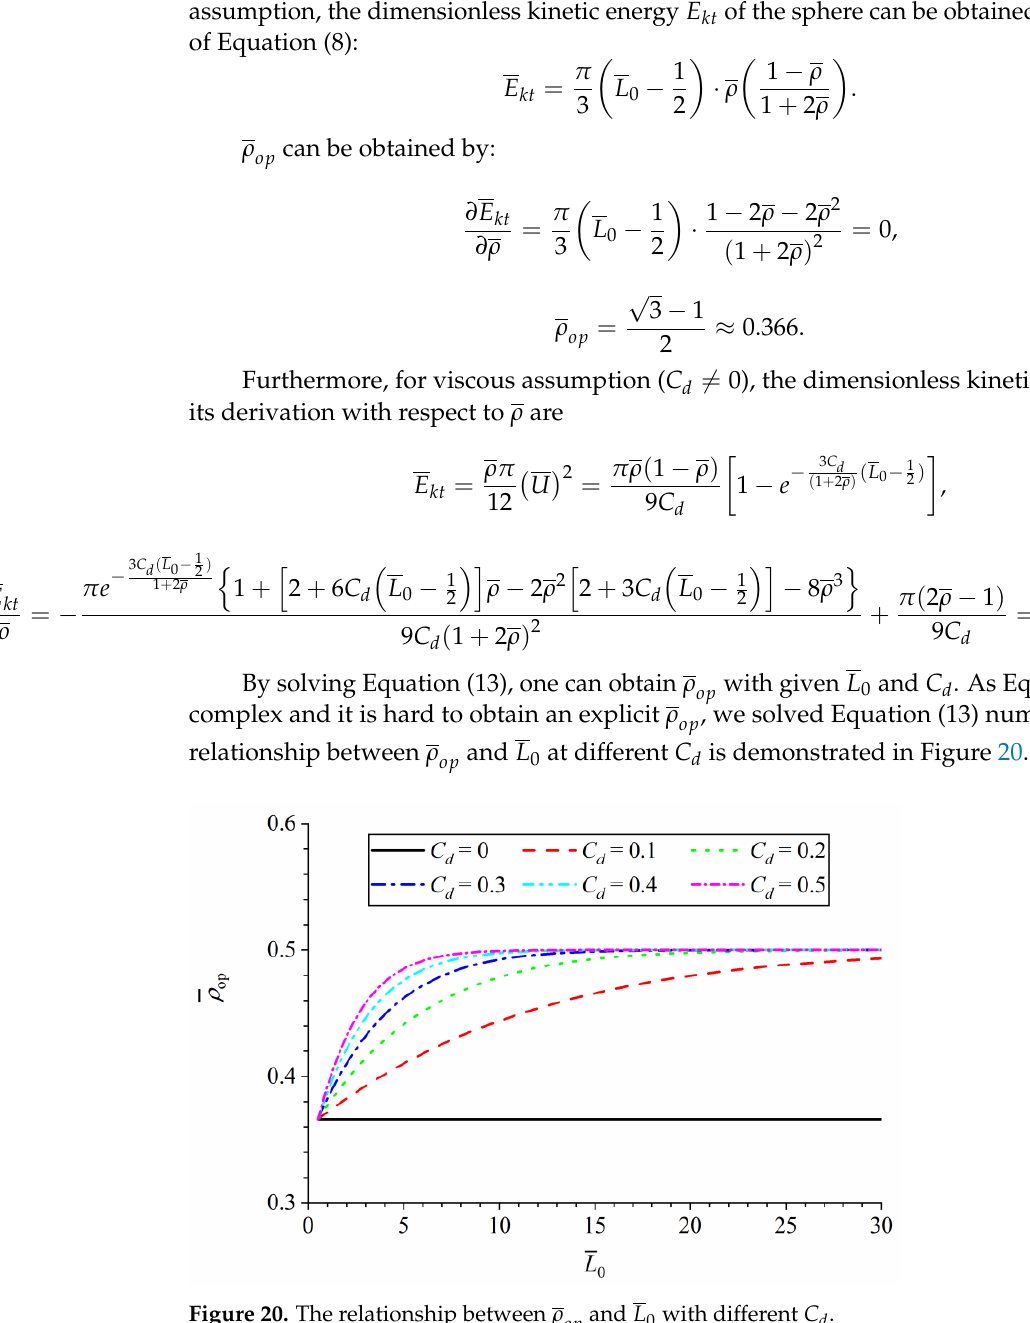
and L 0 with different C d op